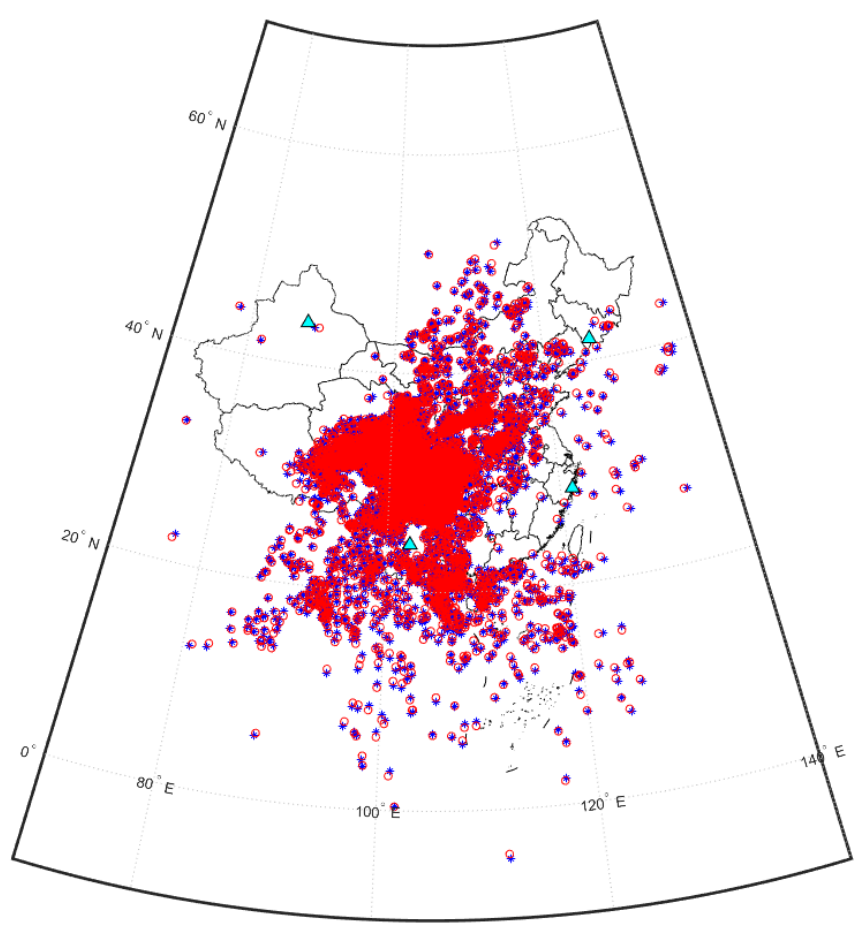
Figure 3. Lightning location results (blue stars) of ELLN (stations are marked as cyan triangles) matched with GLD360’s results (red circles). The lightning localization results of ELLN in this figure are calculated using the speed of light in the air, v 1 .